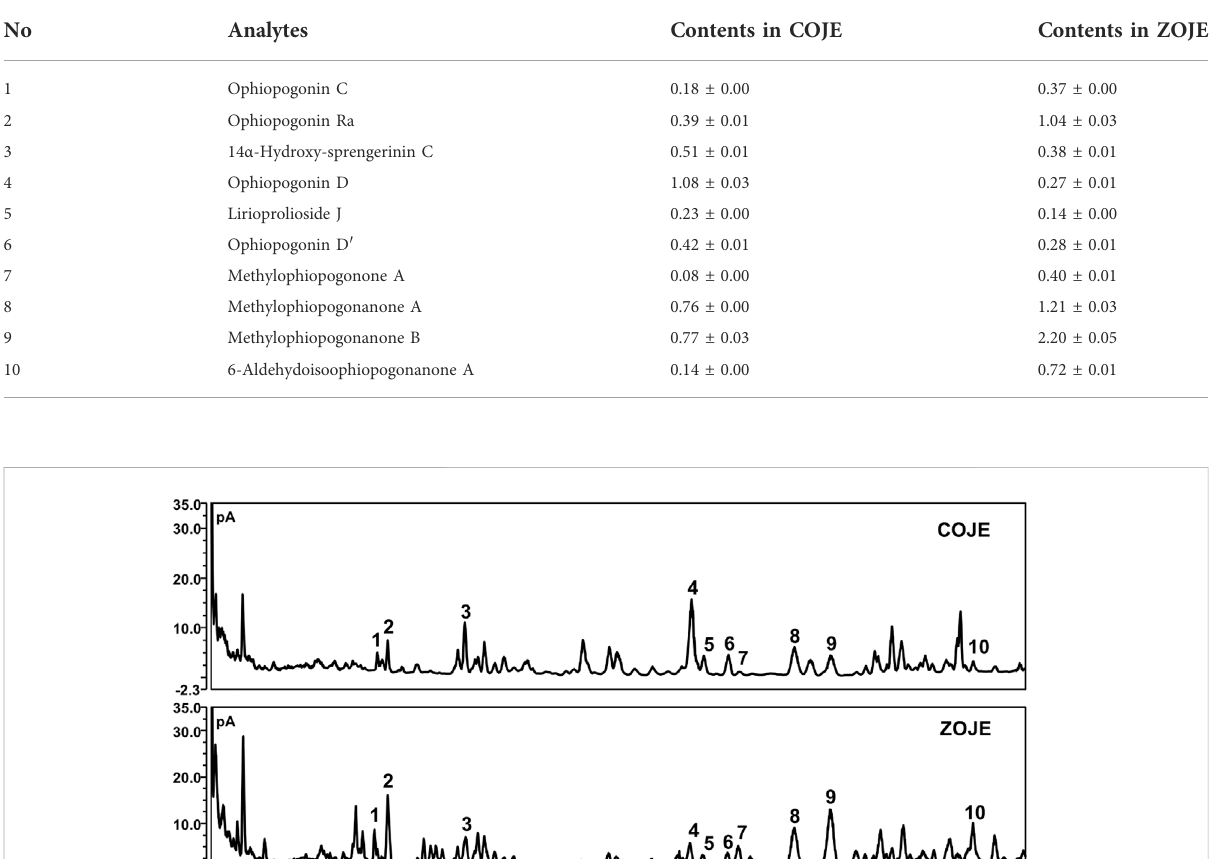
TABLE 1 Contents (mg/g) of six saponins and four homoiso fl avonoids in OJE (n = 3, mean ± SD).